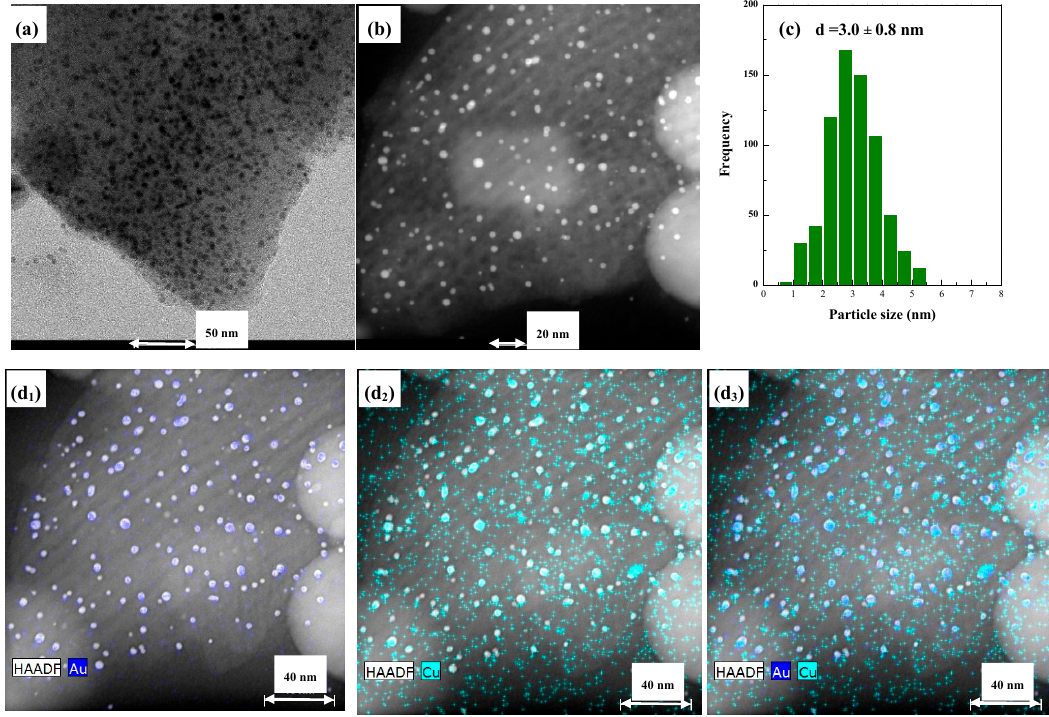
Figure 6. ( a ) TEM, ( b ) STEM, ( c ) particle size distribution and ( d i ) mapping results for AuCu/SBA sample.